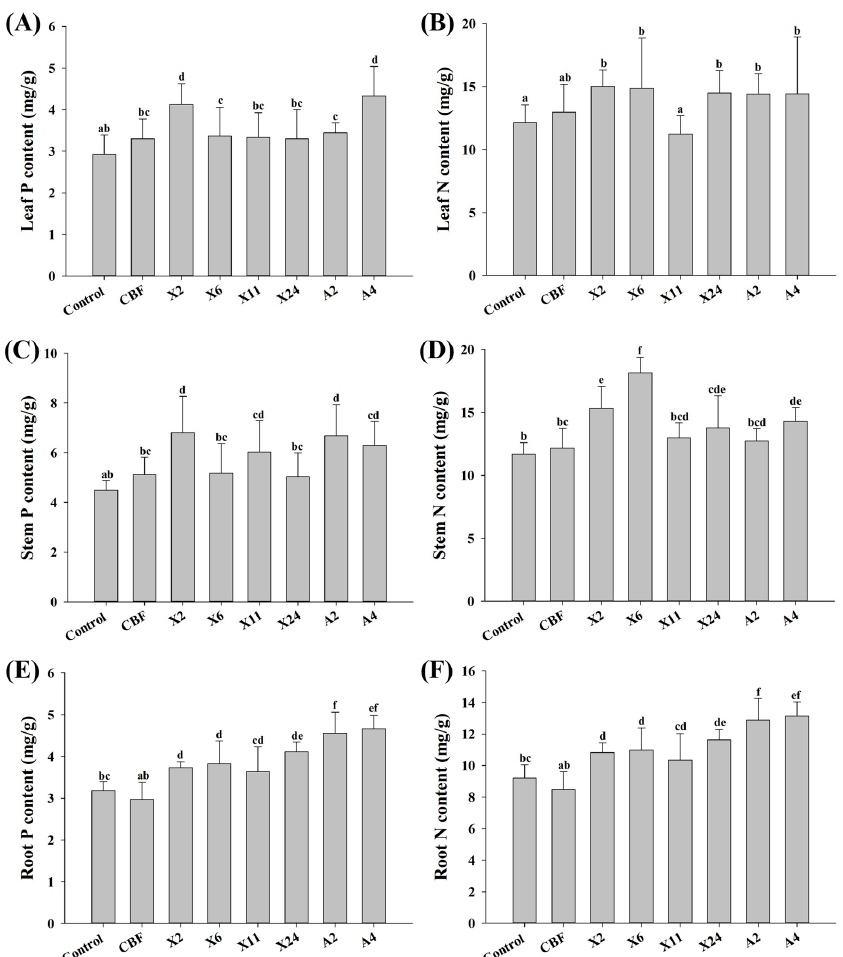
Figure 4. Phosphorus content in ( A ) leaves, ( C ) stems, and ( E ) roots; and nitrogen content in ( B ) leaves, ( D ) stems, and ( F ) roots of blueberry seedlings under different treatment conditions. Control plants were treated with conventional organic fertilizer with nutrient solution, CBF was treated with commercial bacterial fertilizer, and the remaining treatments were treated with conventional organic fertilizer with nutrient solution, then inoculated with beneficial endomycorrhizal fungi isolates. Columns marked with different lowercase letters indicate significant differences ( p < 0.05) between genotypes. Error bars represent the standard error of means ( n = 3).